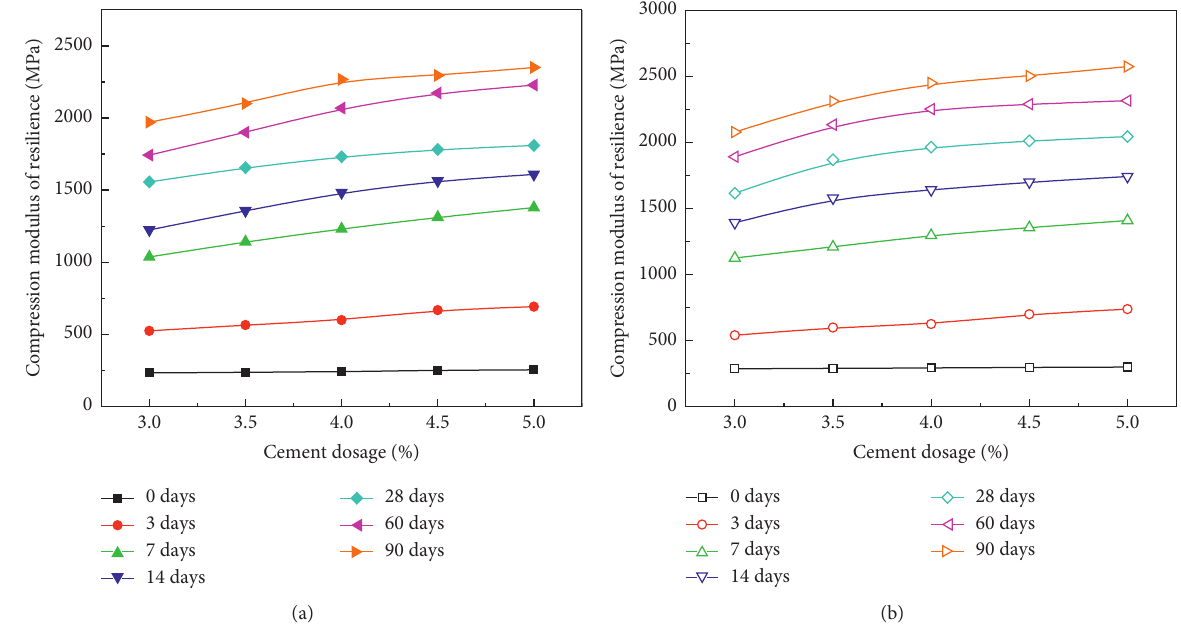
Figure 6: Effect of cement dosage on compression modulus of resilience. (a) GM gradation; (b) XM gradation.